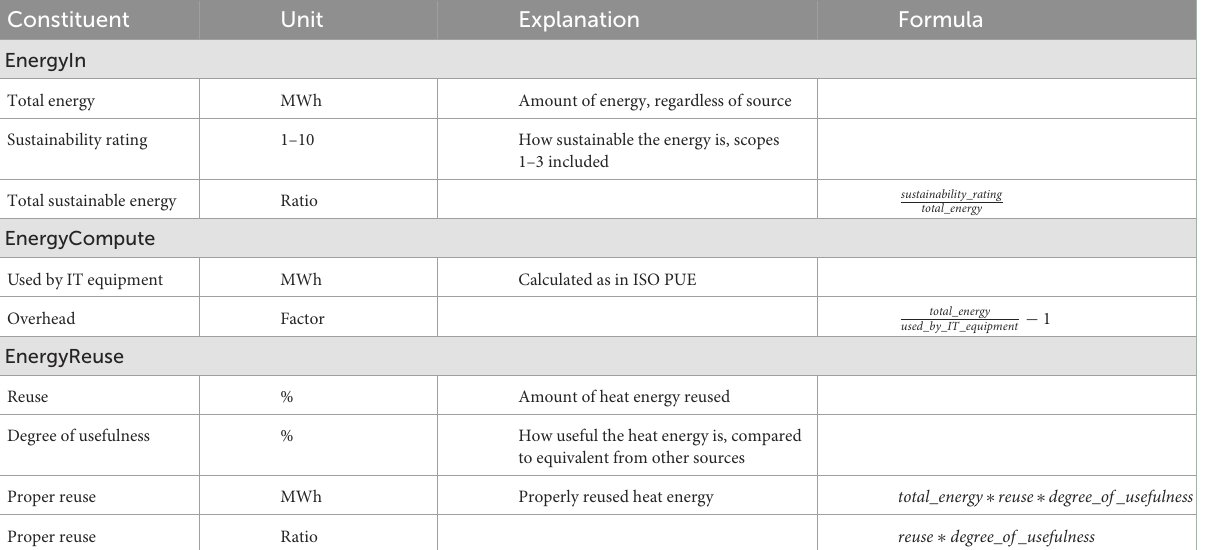
TABLE 2 Constituents of